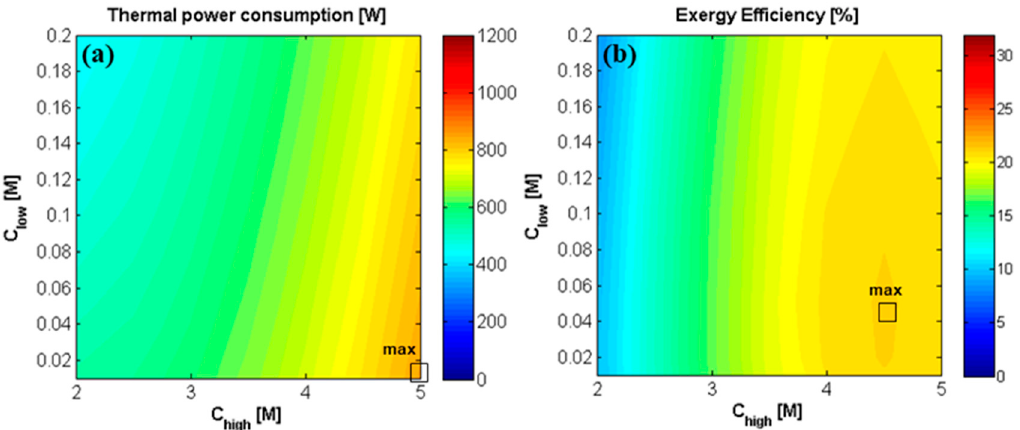
Figure 15. Effect of inlet solutions concentration on ( a ) the thermal power consumption [W] of the MED unit, and on ( b ) exergy efficiency of the RED-MED system. RED stack: 50 cell pairs, ideal membranes, membrane area of 0.1 × 0.88 m 2 , counter-current arrangement, v H , in = v L , in = 1 cm/s. MED: T hot = 100 ◦ C, T cold = 20 ◦ C, optimized number and area of the effects.